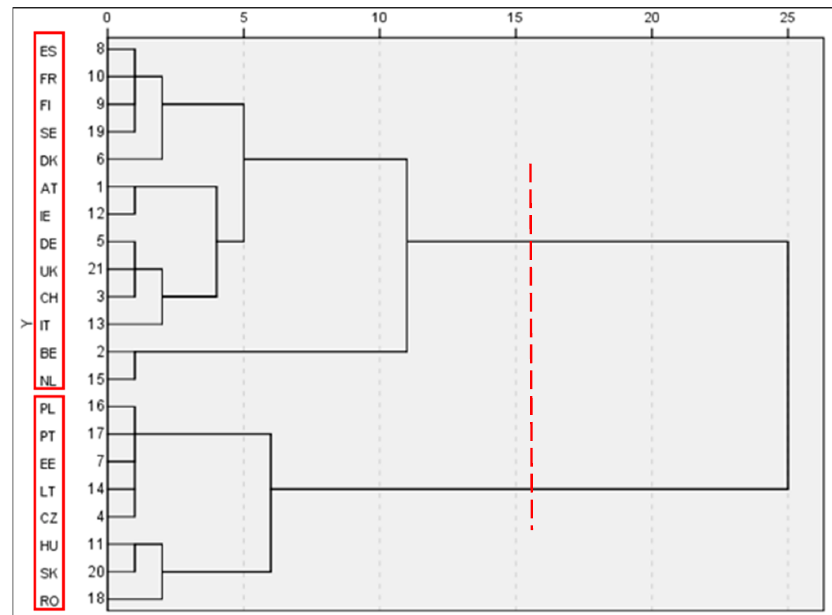
Appl. Sci. 2022 , 12 , x FOR PEER REVIEW Figure 1. The classification tree based on the hierarchical clustering analysis for 2008.